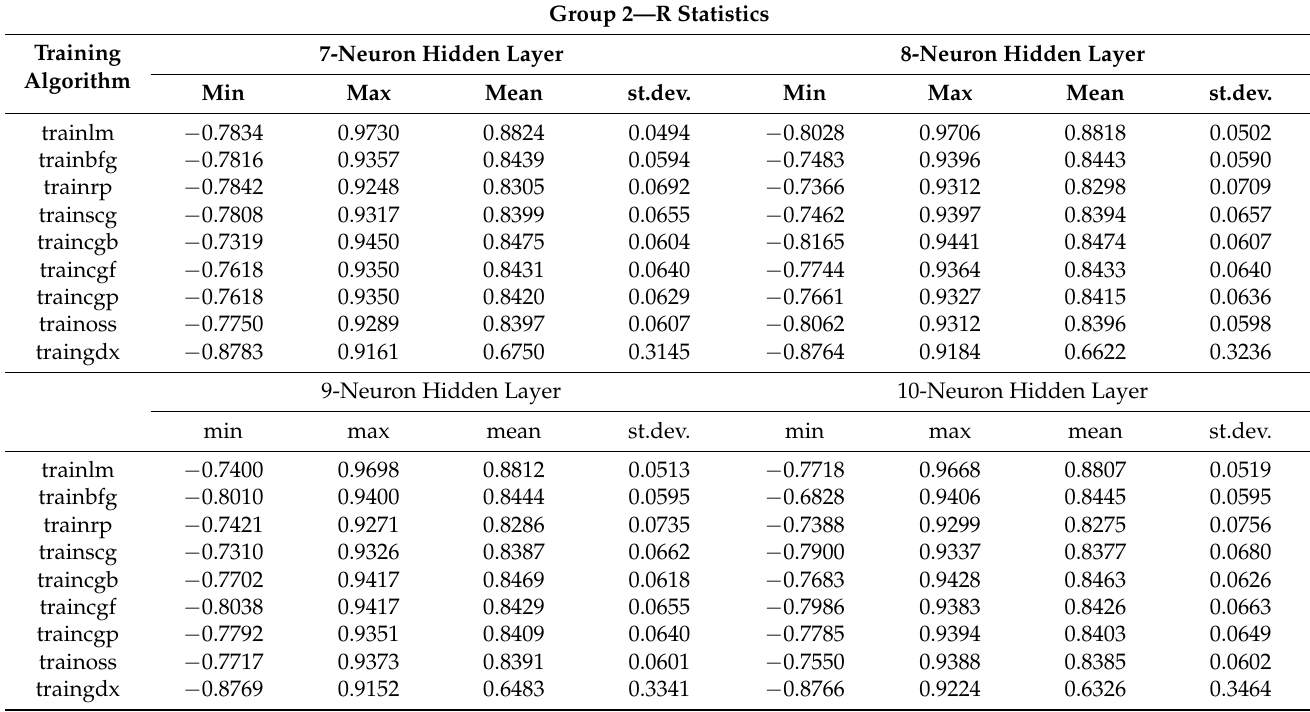
Table 6. Statistics of R—ANNs with input parameters of Group